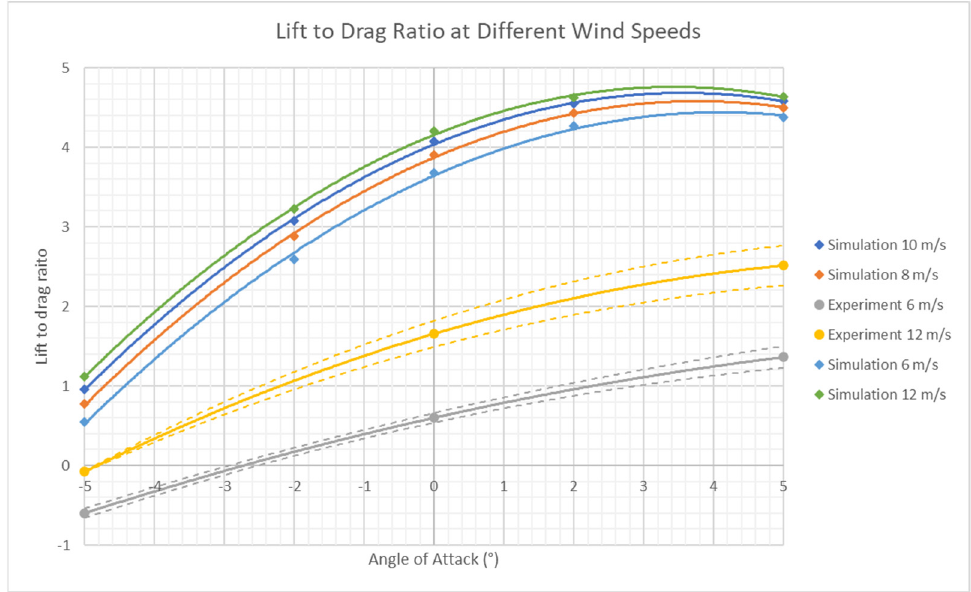
Figure 19. Single blade lift-to-drag ratios with simulation and experiment data, with ±10% error lines for experimental data, represented by dashed lines.